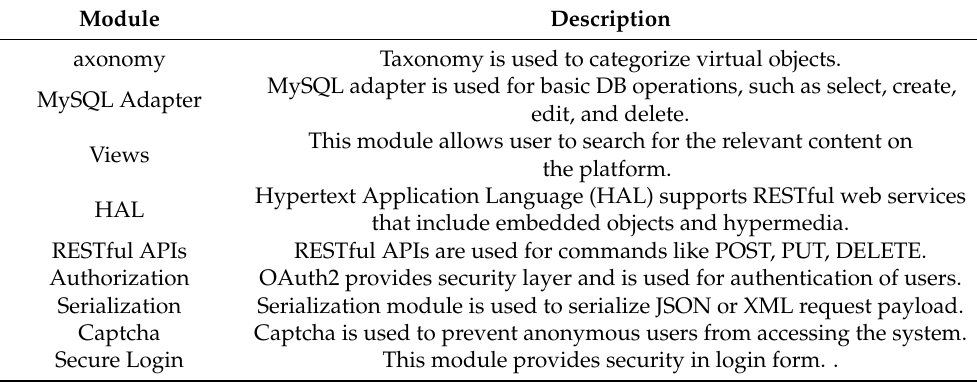
Table 2. Summary of different modules used in the prototype